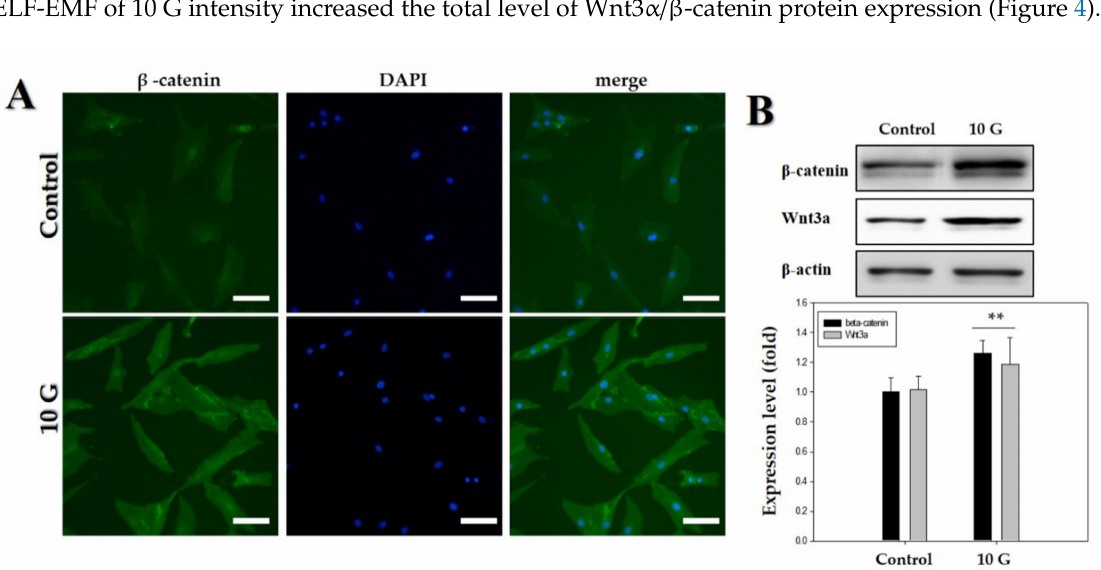
Figure 4. Upregulation of Wnt3 α / β -catenin pathway by an extremely low-frequency electromagnetic field (ELF-EMF) with an intensity of 10 G. ( A ) Immunofluorescence staining of human hair follicle dermal papilla cells (hDPCs) after treatment with ELF-EMF; immunostaining with anti- β -catenin antibody (left panel). Corresponding DAPI nuclear staining is also shown (middle panel), and merged images are shown in the right panel. Original magnification was × 100; bar = 100 µ m; ( B ) hDPCs were treated with ELF-EMF at an intensity of 10 G, and protein expression of Wnt3 α / β -catenin after exposure to ELF-EMFs was analyzed by Western blotting and subsequent quantitative analysis. Expression levels of Wnt3 α / β -catenin were analyzed in comparison with β -actin as the reference gene. ** p < 0.01, compared with